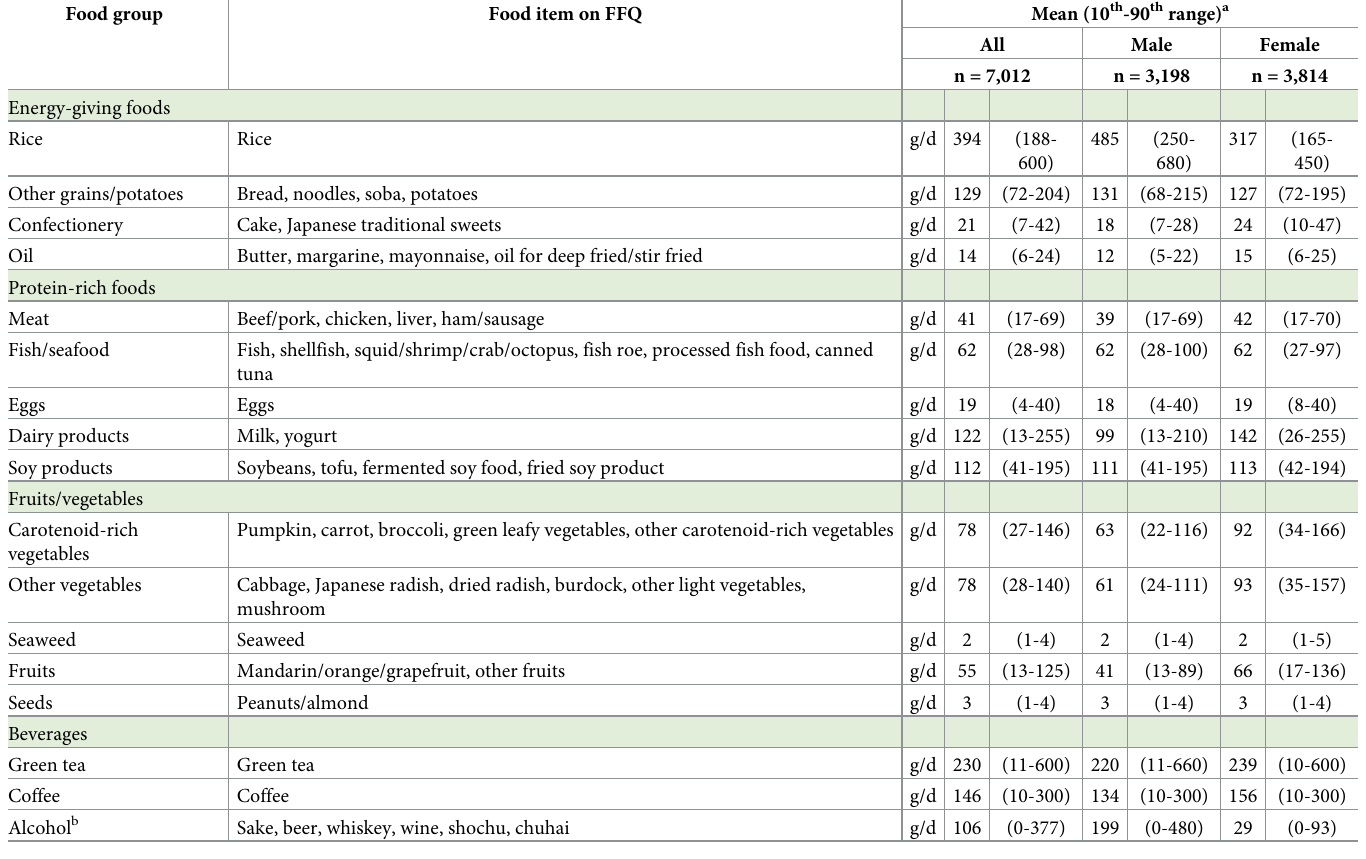
Table 2. Food classification and population intake status. Food group Food item on FFQ